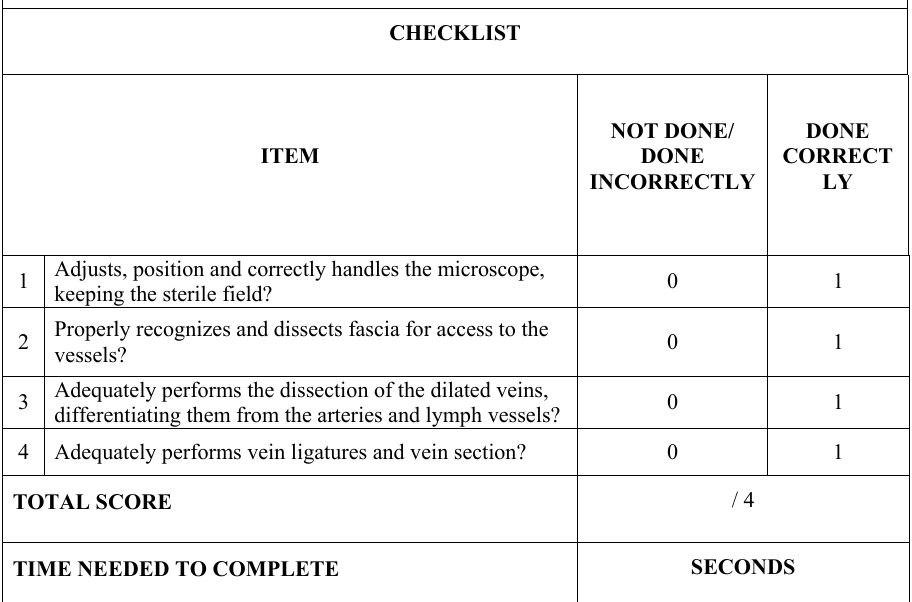
INSTRUCTIONS TO